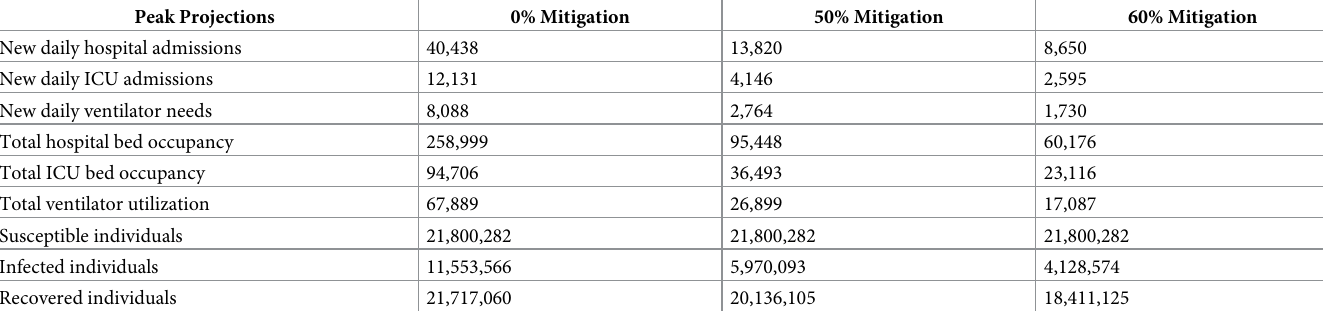
Table 4. Projections of peak health system needs and susceptible, infected, and recovered